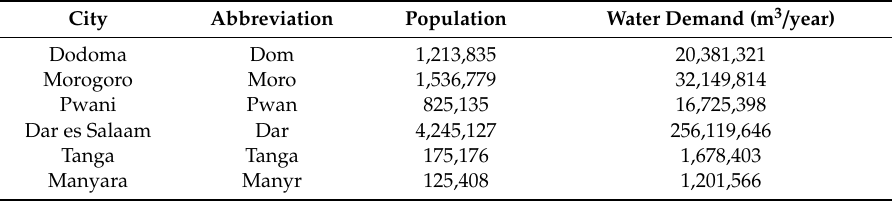
Table 1. Information of the population within the Wami Ruvu